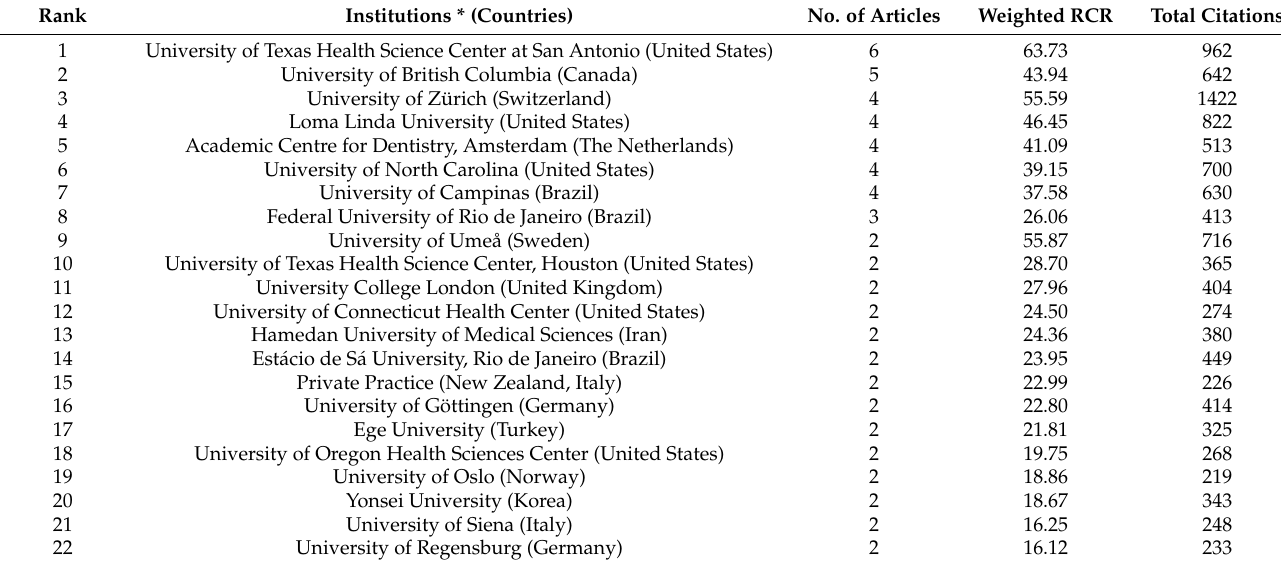
Table 4. Institutions that contributed at least two articles to the top 100 most influential root canal disinfection articles with the highest relative citation rates (RCRs): 1990–2019.